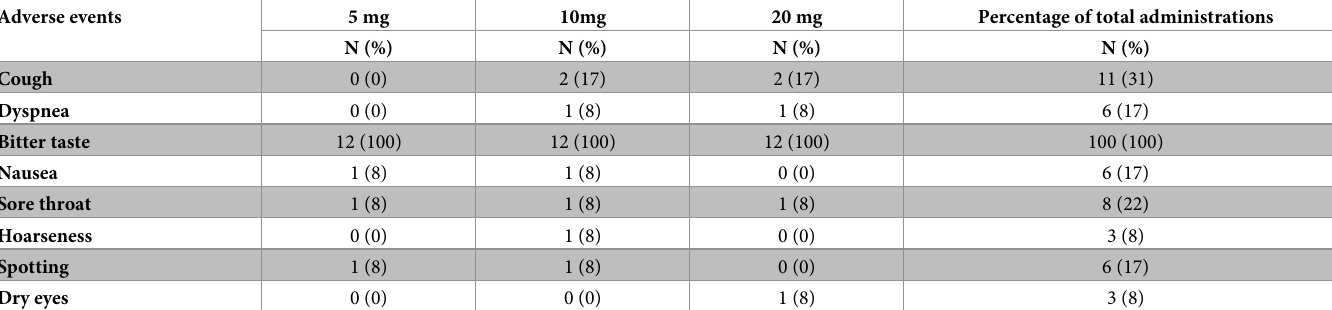
Table 3. Reported adverse events out of 36 HCQ administrations by inhalation in 12 participants.